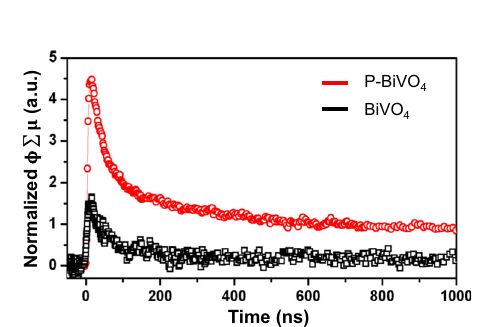
BiVO 4 samplesmeasuredunderrearsideilluminationwithAM1.5Gsimulatedlight. d η sep calculated from the current density-voltage curves for the BiVO 4 and phosphorus-doped BiVO 4